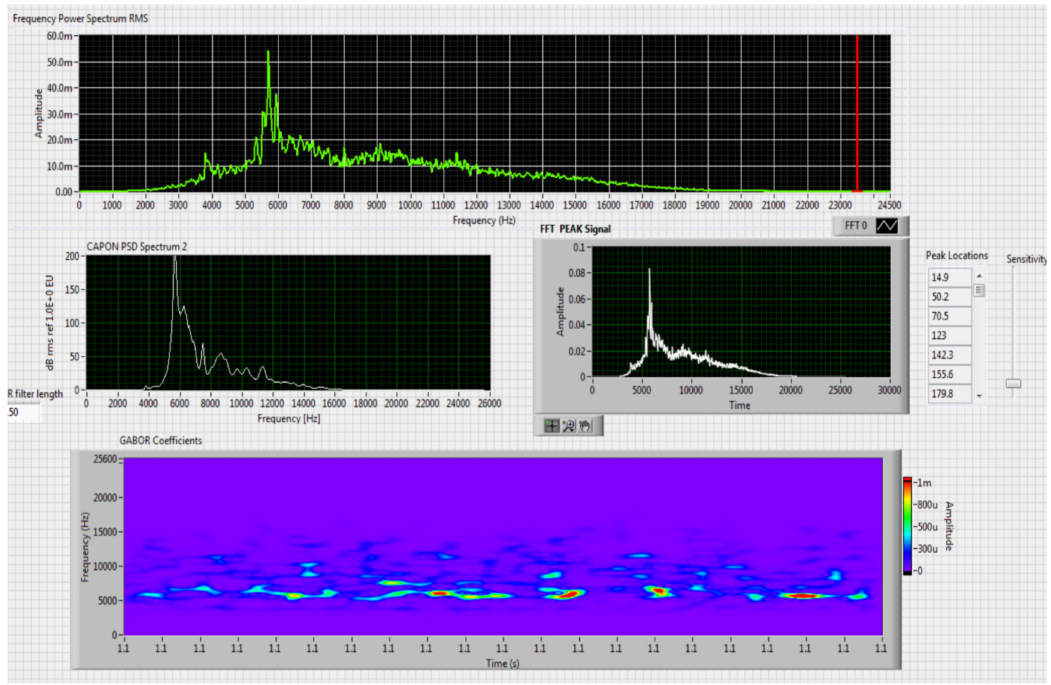
Figure 8. Results obtained for stationary distance 50 m, altitude 3